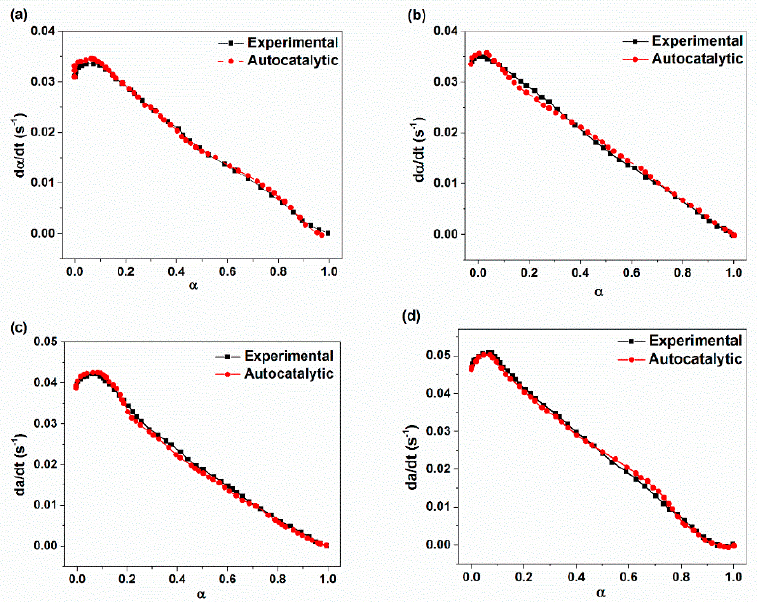
Figure 8. Comparison of experimental conversion rate with predicted ones through using autocata- lytic approach with respect to cure conversion parameter for: ( a ) XE15; ( b ) XE15H3; ( c ) XE15H5; ( d ) XE15H7.